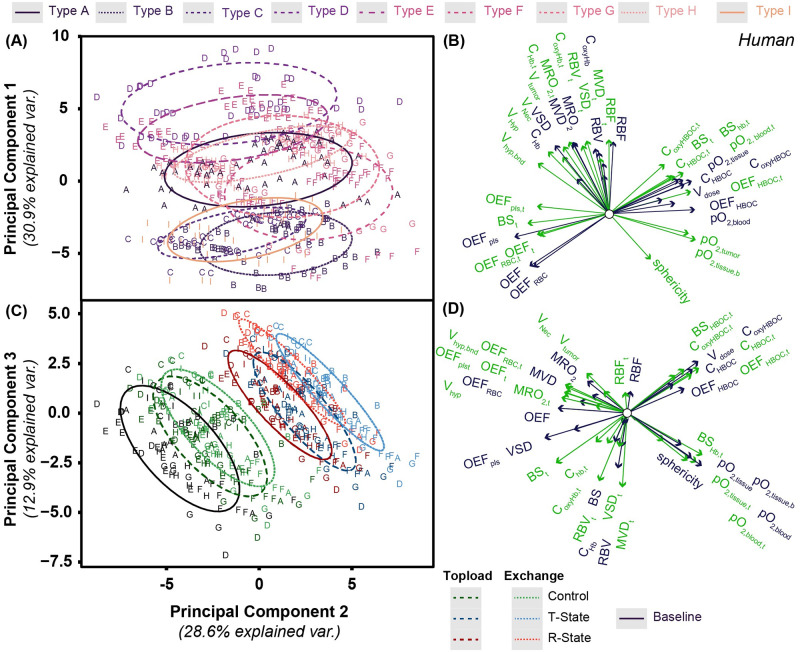
PCA biplot for principal components 1 and 2 for the analysis of the human model.PC scores for tissue properties and O2 delivery for each of the simulated mouse tumor treatments for (A) principal component 1 and (C) principal component 3 as a function of principal component 2. Grouping in panel A is based on tumor vascular bed type. Grouping in panel B is based on dosing type. Ellipses are drawn around each group with 68% of the normal probability. Loading plots relating how each parameter influences the corresponding principal component is shown for (B) principal component 1 and (D) principal component 3 as a function of principal component 2. Loading vectors with magnitude less than 0.5 have been excluded from this plot. Green vectors indicate tumor properties while blue vectors indicate host tissue properties. Labels on each vector indicate the corresponding tumor property.